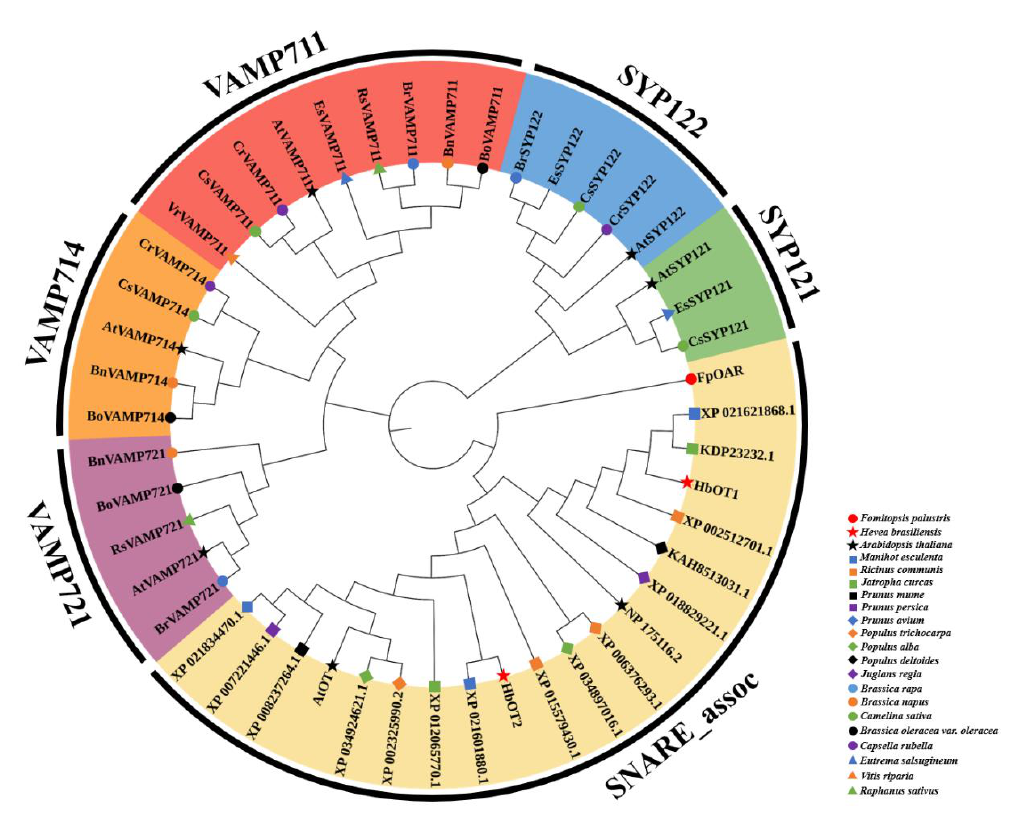
Figure 4. Phylogenetic analysis of FpOAR, HbOT1, and HbOT2 and SNARE protein members in other plants. All amino acid sequences were obtained from the database of NCBI (https://www.ncbi.nlm.nih.gov/) accessed on 7 November 2020, with the GenBank accession numbers indicated. The complete protein sequences were aligned using MEGA 7, and the phylogenetic tree was constructed using the neighbor-joining method and displayed using iTOL (https://itol.embl.de/).